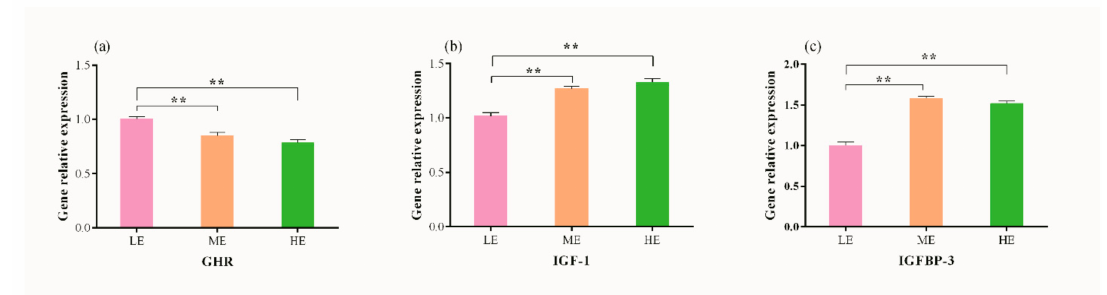
Figure 2. Effect of different dietary energy levels on relative expression of hepatic genes. ( a ) GHR, growth hormone receptor; ( b ) IGF-1, insulin-like growth factors 1; ( c ) IGFBP-3, insulin-like growth factor binding protein 3. Data are shown as mean ± SEM (standard error of mean). Within the same gene, * and ** indicate p < 0.05 and p < 0.01, respectively.